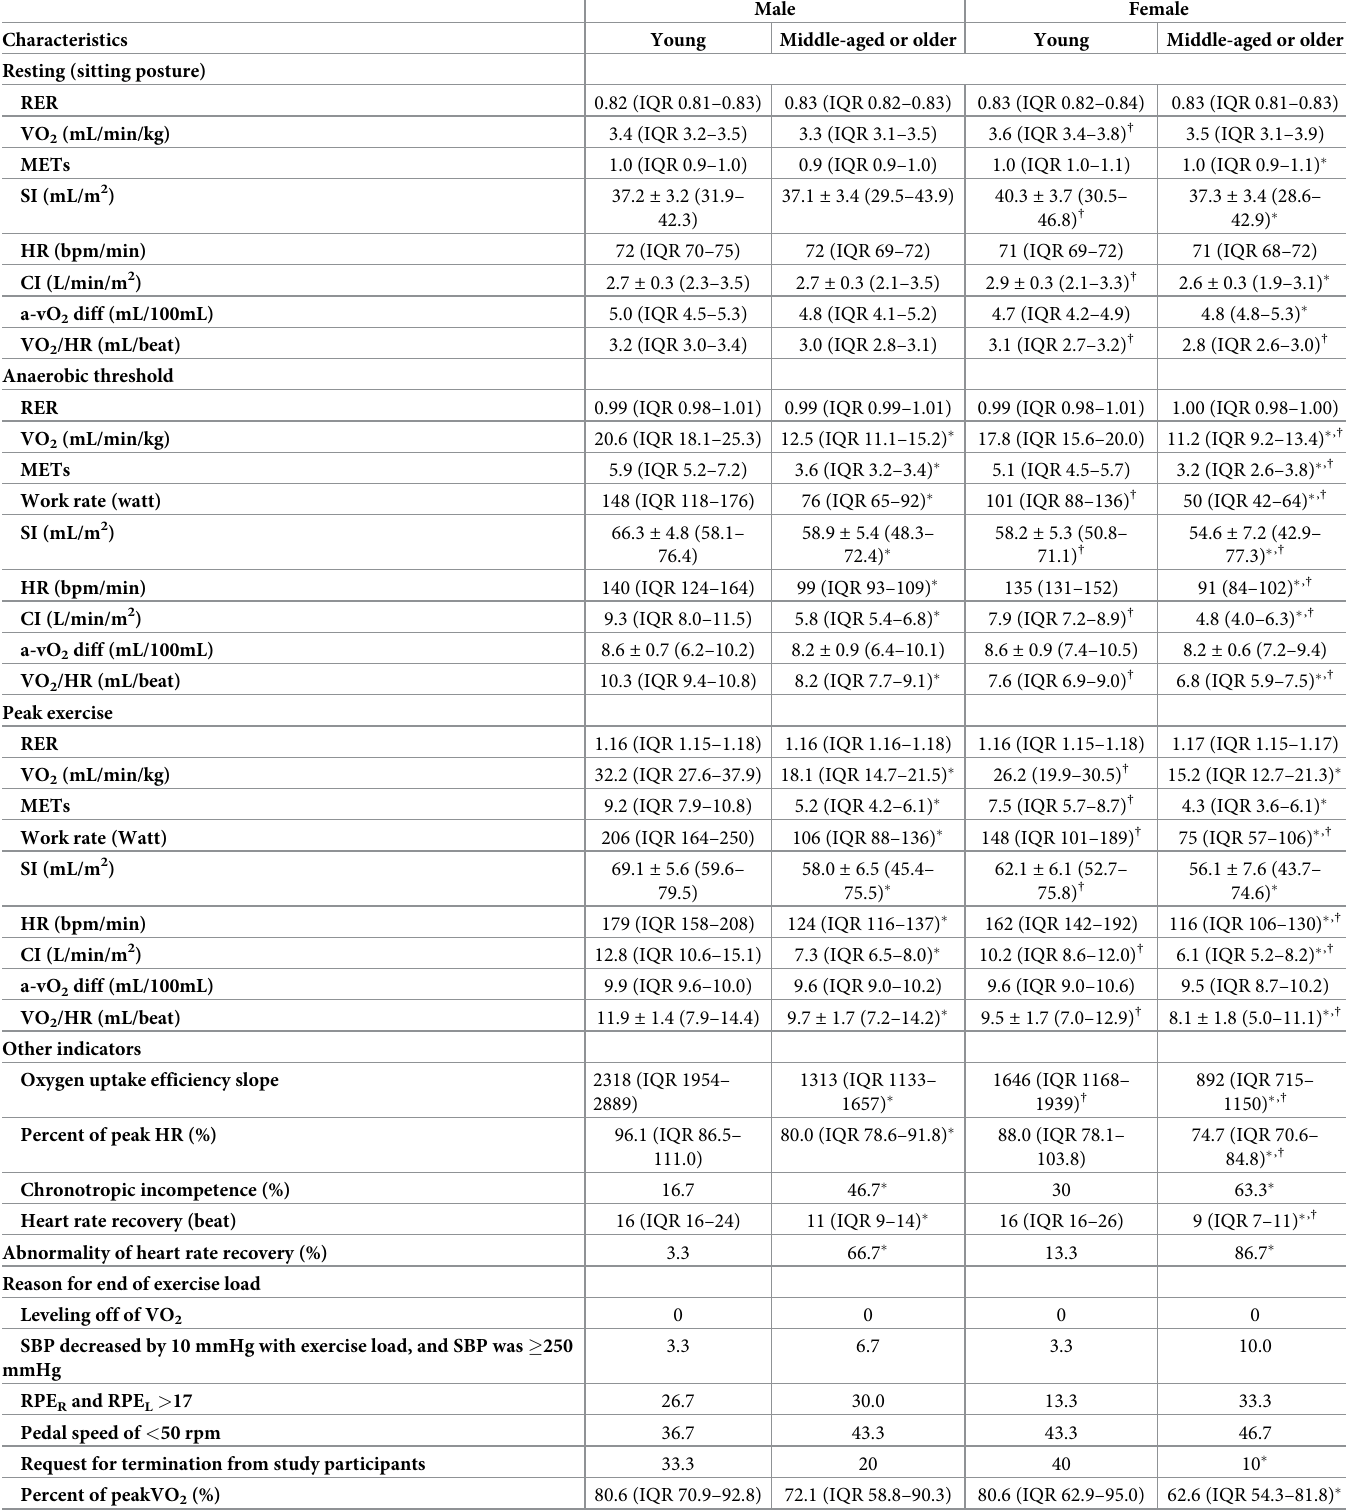
Table 2. Cardiopulmonary exercise testing and hemodynamics of participants classified by age and sex.